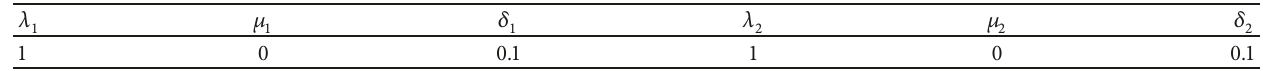
Table 2: parameter values.